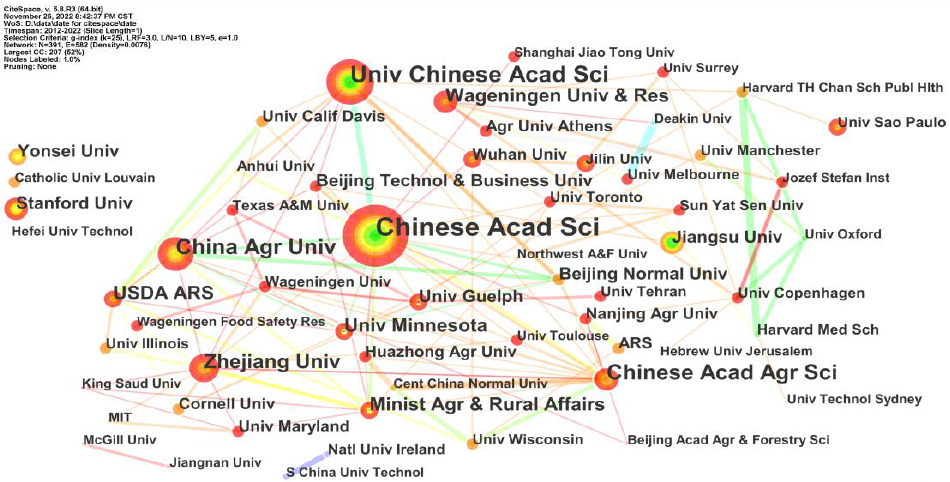
Figure 10. The institute co-authorship network of AI-related publications.